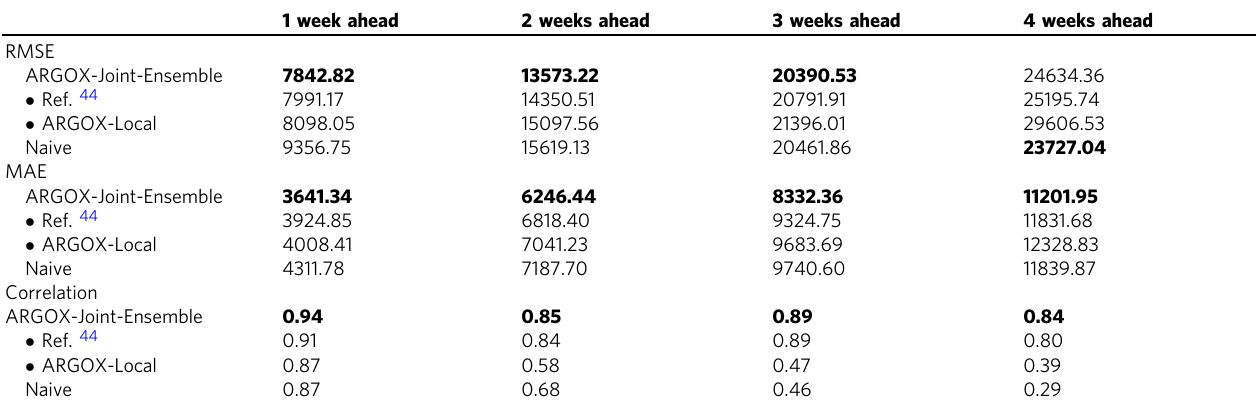
Table 3 Comparison of different methods for state-level COVID-19 1 – 4 weeks ahead cases predictions in 51 U.S.